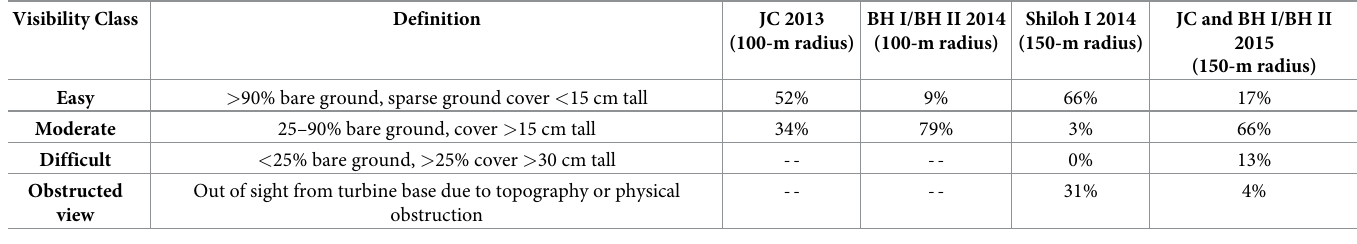
Table 2. Visibility class definitions and percent coverages within searched areas a during searcher efficiency trials at the Juniper Canyon (JC), Big Horn I (BH I), Big Horn II (BH II), and Shiloh I wind energy facilities. Visibility